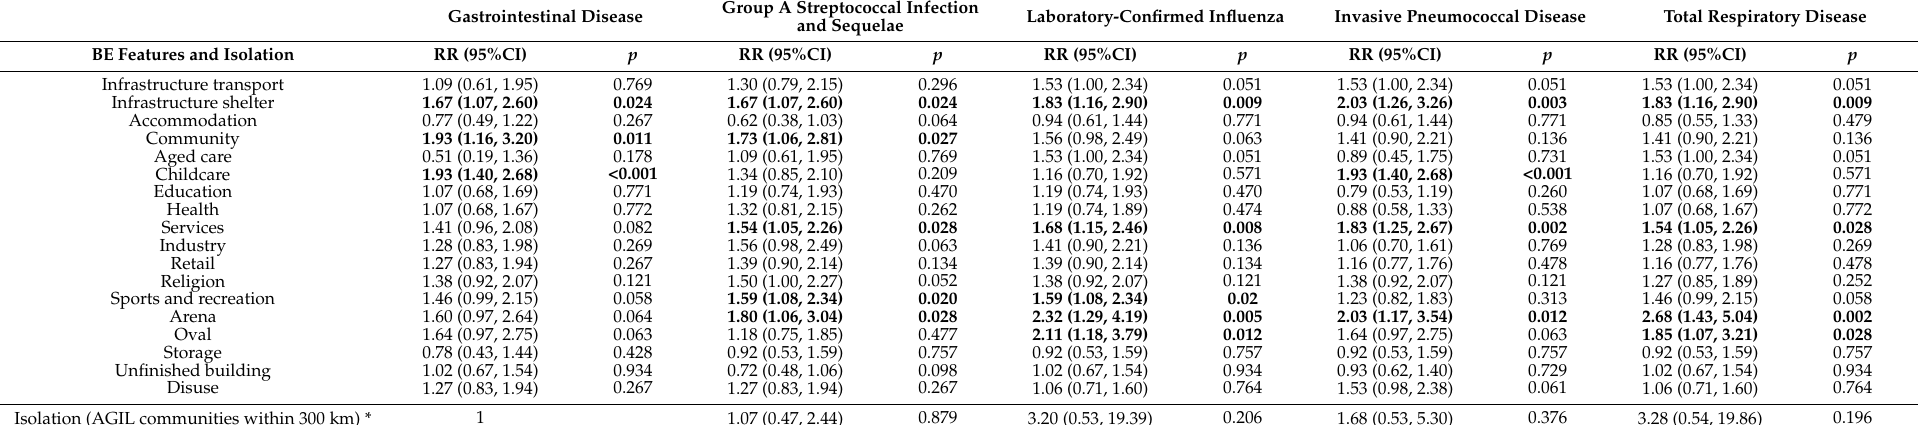
Table 2. Bivariate binomial regression of infectious disease outcomes on built environmental features and geographic